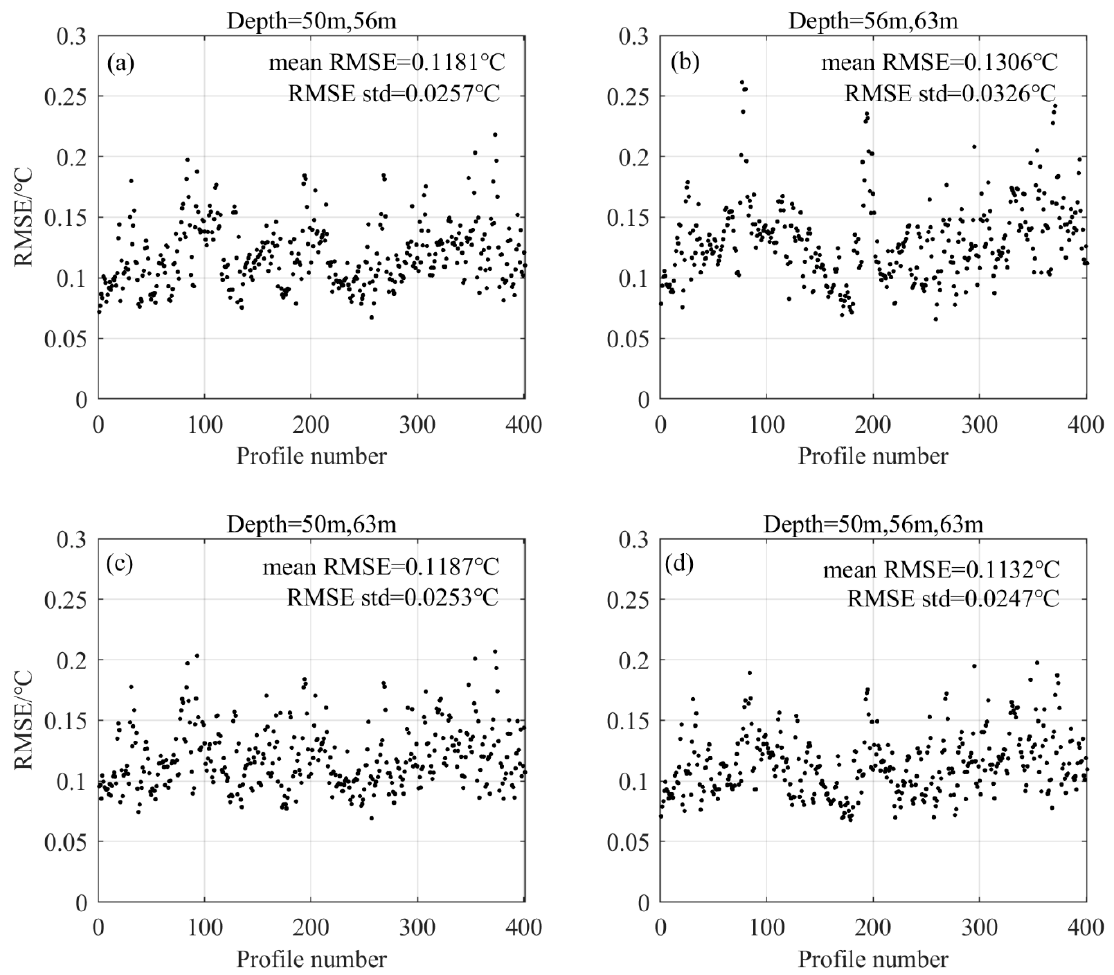
Figure 11. The mean RMSE of inversion temperature profiles by temperatures at depths of 50, 56 m and 63 m. The depths of the input temperatures are ( a ) 50 m and 56 m, ( b ) 56 m and 63 m, ( c ) 50 m and 63 m, ( d ) 50 m, 56 m and 63 m.